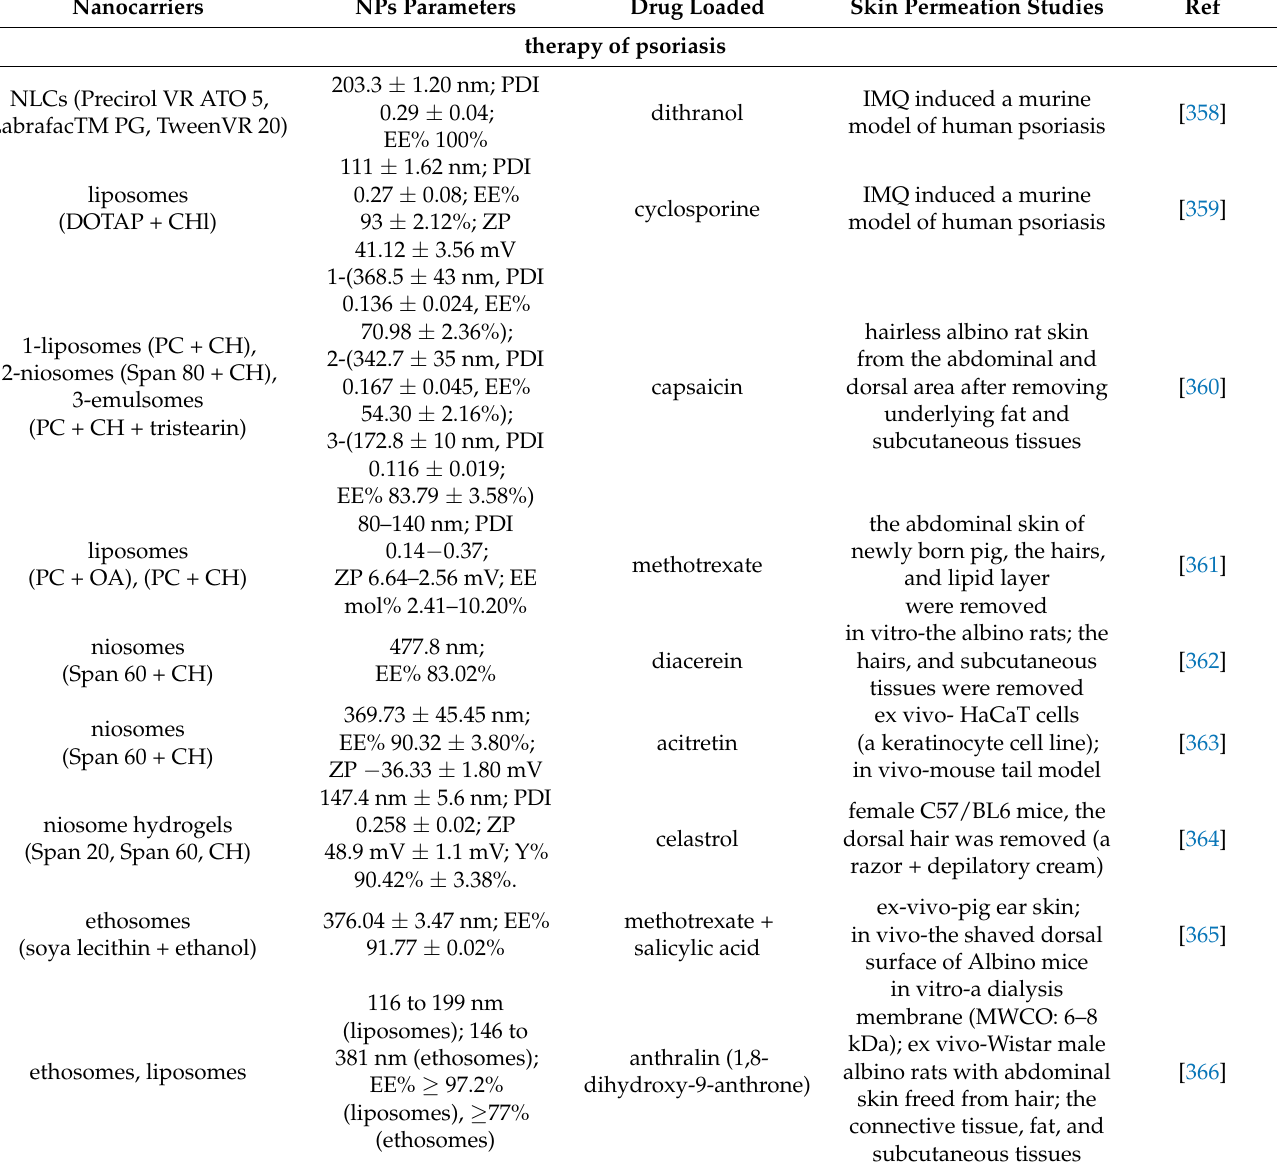
Table 1. Recent developments of drug-loaded NPs for topical treatments of skin